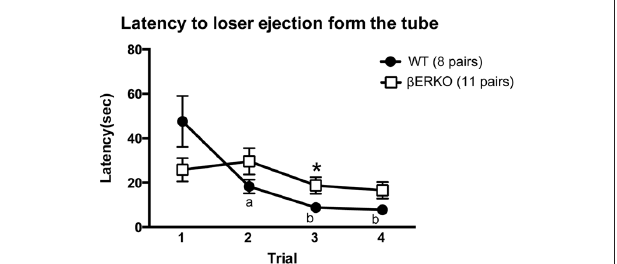
FIGURE 2 | Influence of ER β gene disruption on the latency to loser ejection in • the tube test. Unlike WT ( ), β ERKO ( (cid:3) ) mice did not show a decrease in the latency to loser ejection over trials. Data are presented as mean ± SEM. a p < 0.05; b p < 0.01 compared with trial 1 of the same genotype; ∗ p < 0.05 compared with WT in the same trial.